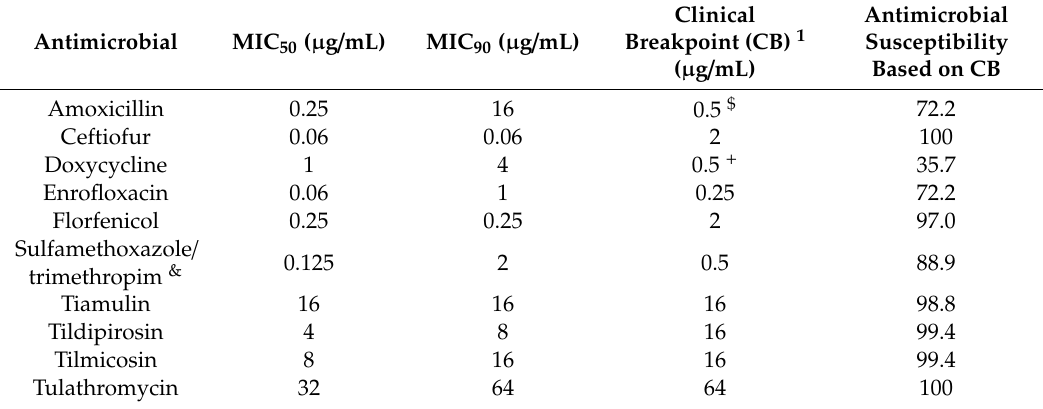
Table 2. Actinobacillus pleuropneumoniae (APP), MIC 50 , MIC 90 , current recommended clinical breakpoints (CB) and antimicrobial susceptibility. The MIC 50 and MIC 90 were determined from the MIC distribution from 162 APP strains isolated from respiratory clinical cases. The antimicrobial susceptibility was calculated as the percentage of bacterial isolates below CB.